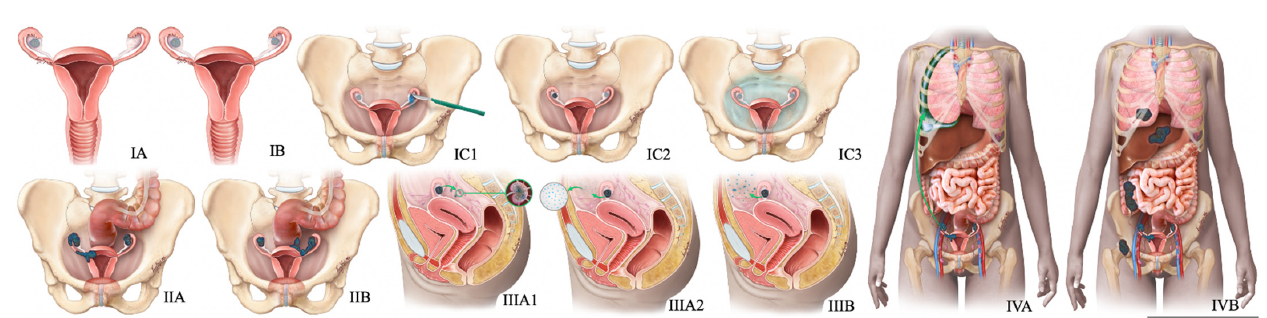
Figure 8. FIGO staging system for ovarian cancer. In stage IA cancer, the tumor is limited to one ovary or fallopian tube. The tumor is limited to both ovaries or fallopian tubes in stage IB cancer. Stage IC1 cancer results from the intraoperative spill. In stage IC3 cancer, malignant cells are found in ascites or peritoneal washings. In stage IIA, the tumor extends to or is implanted on (or both) uterus or fallopian tubes (or both). Stage IIIA1 cancer shows positive retroperitoneal lymph nodes. Stage IIIA2 cancer, microscopic, extrapelvic (above pelvic brim) peritoneal involvement is seen with or without positive retroperitoneal lymph nodes. Stage IIIB or stage IIIC cancer, macroscopic, ex- trapelvic (above pelvic brim) peritoneal involvement is seen with or without positive retroperitoneal lymph nodes ( ≤ 2 cm for stage IIIB and >2 cm for stage IIIC). Stage IVA cancer indicates pleural effusion with positive cytology. Stage IVB cancer, hepatic or splenic parenchymal metastasis is seen (or both) and metastasis to extra-abdominal organs.